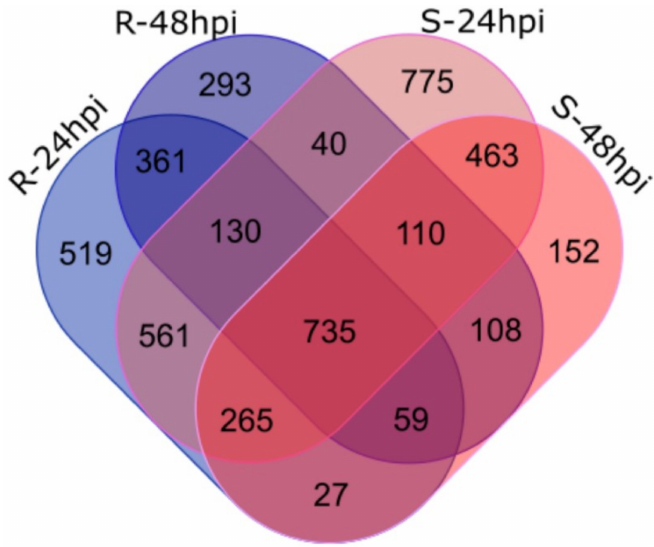
Figure 4. Venn diagram analysis of differentially expressed genes (DEGs). DEGs from treatment vs control comparisons of both Sp-R and Sp-S at 24 and 48 hpi. Pink ovals represent Sp-S treatment vs control and blue represents Sp-R treatment vs. control